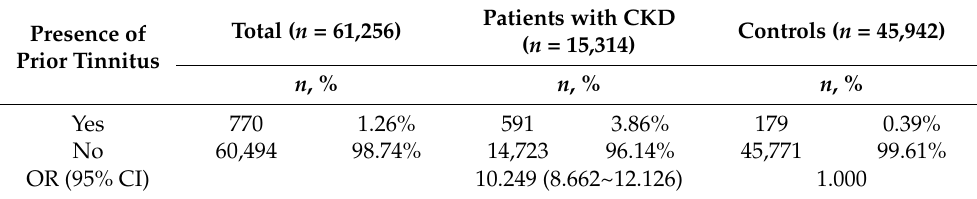
Table 2. Prevalence of prior tinnitus, crude odds ratios (ORs) for tinnitus, and 95% confidence intervals (CIs) among cases with CKD vs.